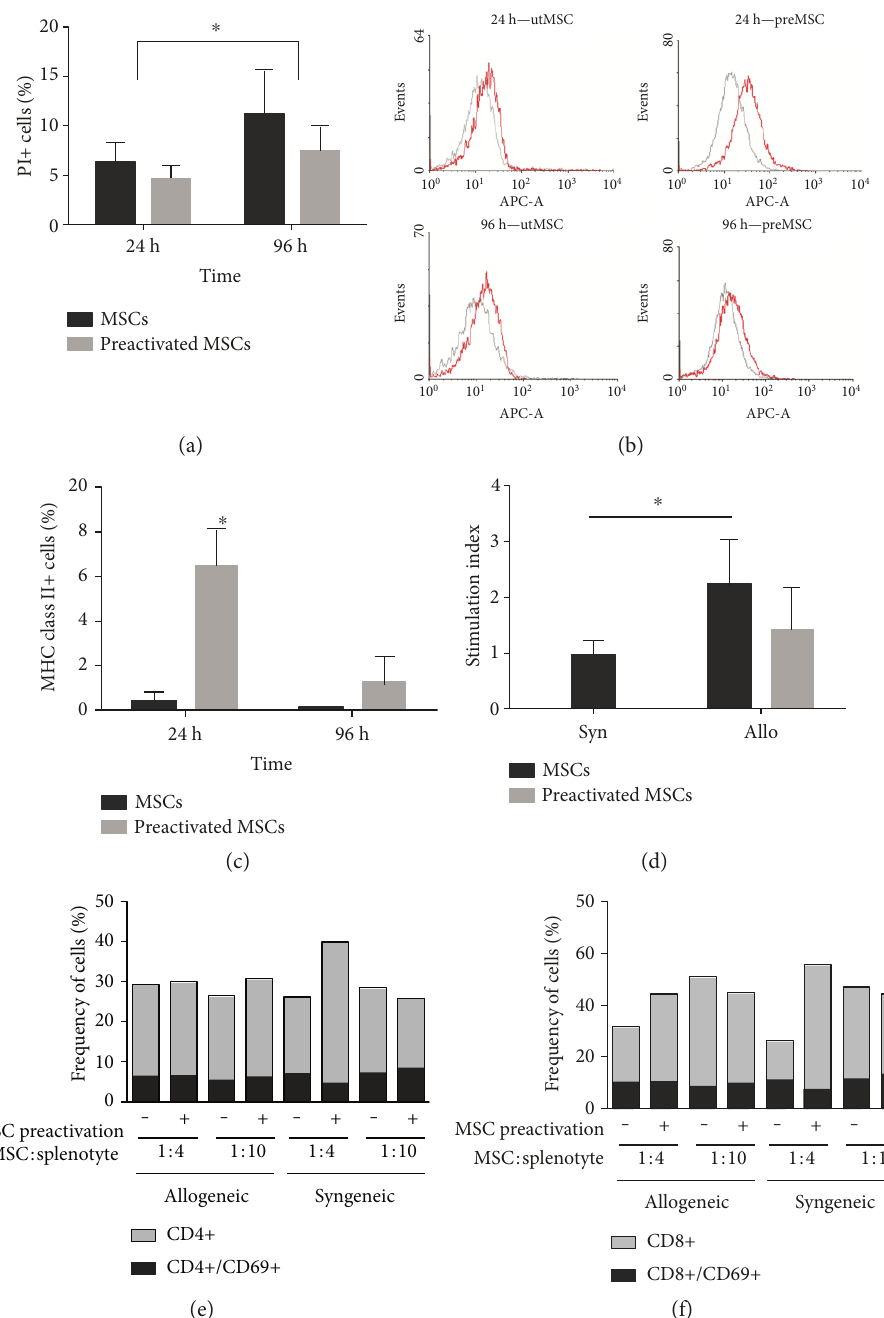
Figure 2: Cellular characterization after preactivation of MSCs. Viability test and MHC class II expression were performed 24 h and 96 h after MSC preactivation with 20 ng/mL IFN- γ and 30ng/mL TNF- α for 20 h. The frequency of dead cells (a) in the preactivated and untreated groups was estimated by propidium iodide incubation and fl ow cytometry analysis ( n = 3 ). MHC-II expression (b) was assessed by anti- MHC class II antibody (red peaks) and isotype control (grey peaks) on the preactivated and untreated MSCs after 24 and 96h. The frequency of MHC class II-positive cells (c) from three independent experiments is presented ( n = 3 ). Splenocyte proliferation assay was performed by coculture of splenocytes with preactivated and untreated allogeneic or syngeneic MSCs. Proliferation was measured by BrdU incorporation after 72 h coculture with the preactivated and untreated MSCs (d). The stimulation index (SI) was calculated by the ratio between the absorbance of the MSC/splenocyte coculture group and the splenocytes only (control group). Analysis of activated T cells after coculture for 72 hours with syngeneic or allogeneic mesenchymal stem cells (e and f). No statistically signi fi cant di ff erences were found in the frequency of activated T helper cells (CD4 + /CD69 + ) (e) or T cytotoxic cells (CD8 + /CD69 + ) (f) when splenocytes were cocultured with syngeneic or allogeneic MSCs at 1 :4 or 1 :10 MSC to splenocyte rates ( n = 3 ). Two-way ANOVA, post hoc Tukey. Allo: allogeneic MSCs; Syn: syngeneic MSCs. Signi fi cant di ff erence betweenallogeneic ( n = 5 ) and syngeneic ( n = 3 ) groups. Two-way ANOVA, post hocTukey. ∗ P < 0 05